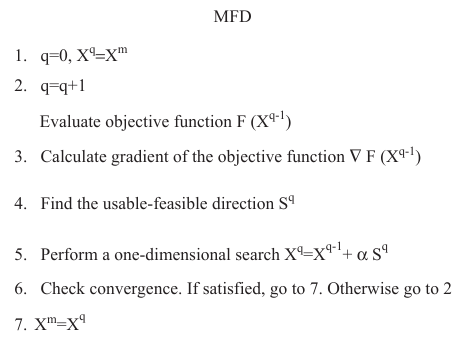
Figure 2 Flow chart of